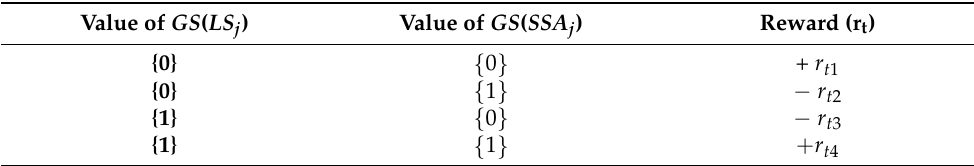
Table 2. Reward table. Value of GS ( LS j